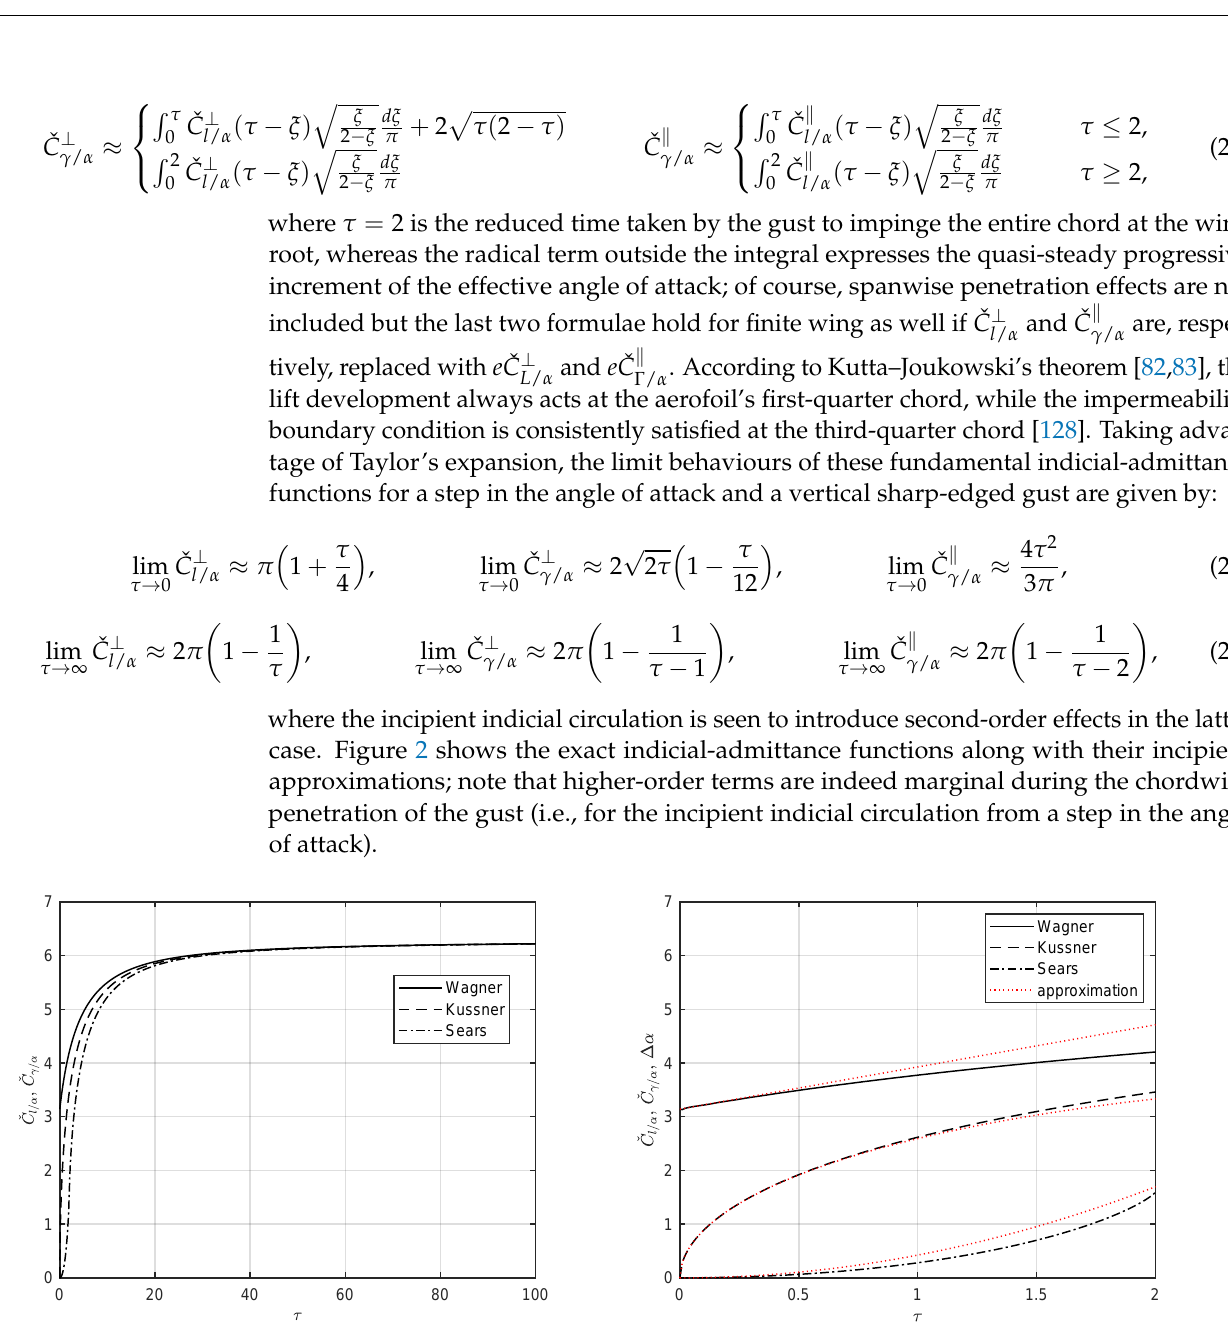
Figure 2. The indicial airload derivatives ( left ) and approximate incipient behaviours ( right ) for thin aerofoil in incompressible